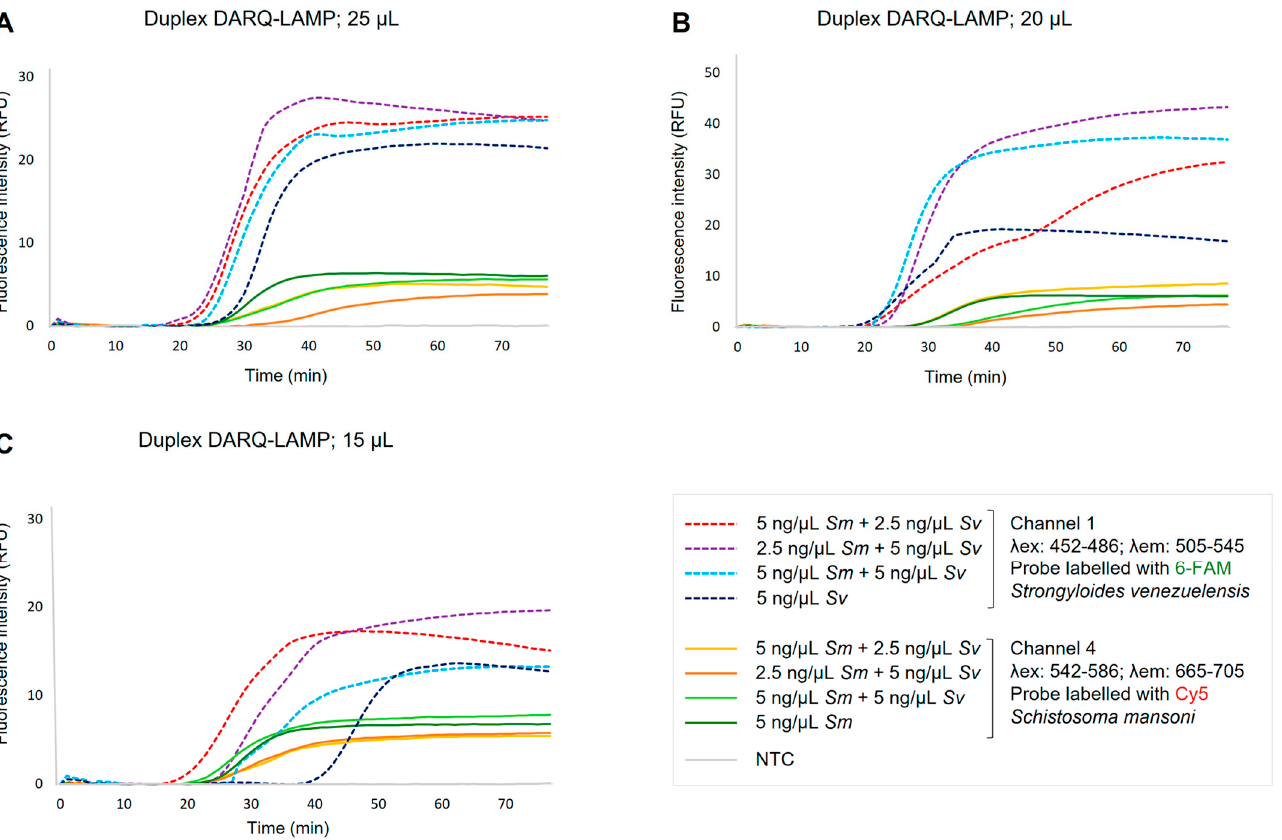
Figure 3. Duplex DARQ-LAMP for simultaneous amplification of gDNA from Schistosoma mansoni and Strongyloides venezuelensis using different combinations of gDNA concentrations as template in different volumes of master mixes. ( A ) Duplex DARQ-LAMP in 25 µL. ( B ) Duplex DARQ-LAMP in 20 µL. ( C ) Duplex DARQ-LAMP in 15 µL. Combinations of gDNA concentrations of the two parasites used as templates are indicated on the right panel. NTC, non-template control (ultrapure water instead gDNA). The reactions were carried out in a PCR max Eco 48 Real Time PCR System. Dotted lines indicate fluorescence reading in channel 1 for Strongyloides venezuelensis amplification (probe labelled with 6-FAM) and continuous lines indicate fluorescence reading in channel 4 for Schistosoma mansoni amplification (probe labelled with Cy5).